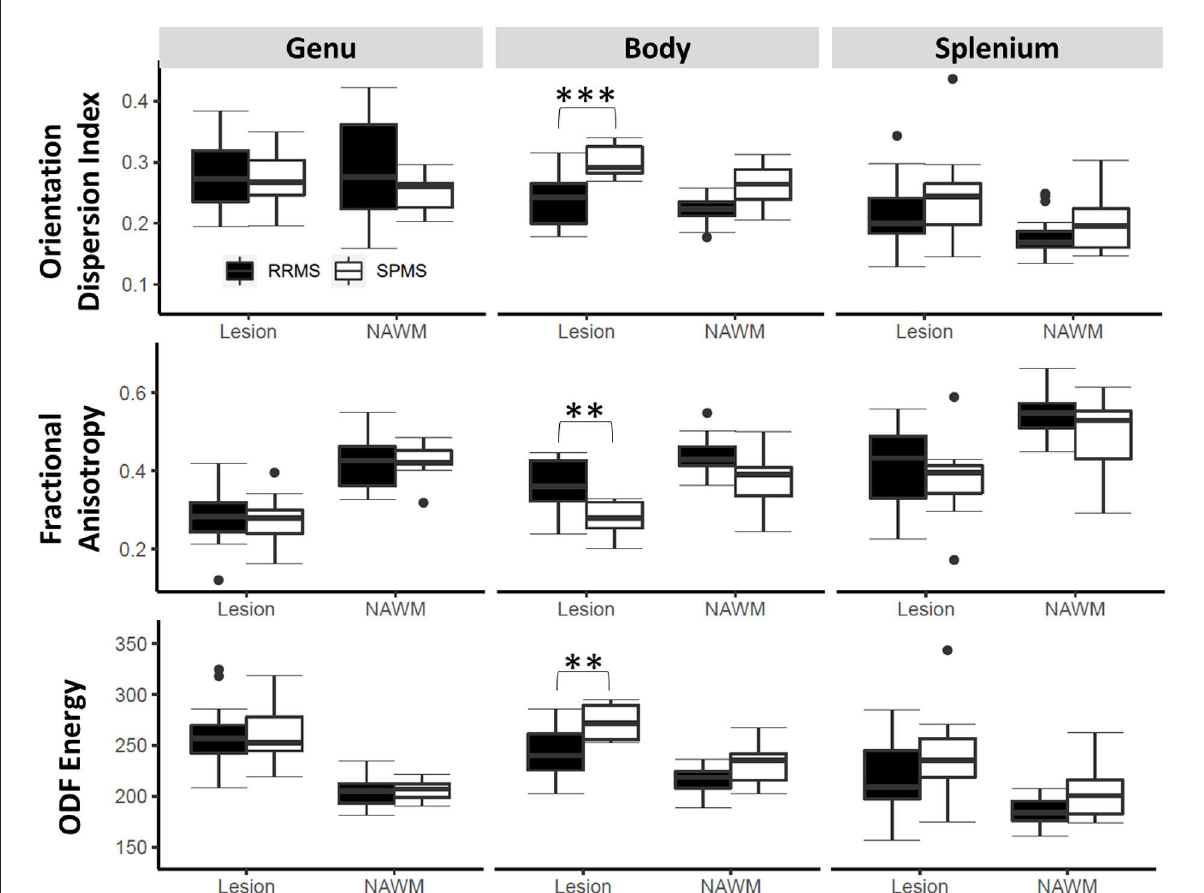
FIGURE5 Tract ROI-based outcomes by cohort. Shown are findings in three diffusion measures on lesions and normal appearing white matter (NAWM) within three key regions of the corpus callosum. The stars indicate post hoc significance: * p < 0.05, ** p < 0.01, *** p < 0.001. The boxes plot the median, interquartile range (IQR), and